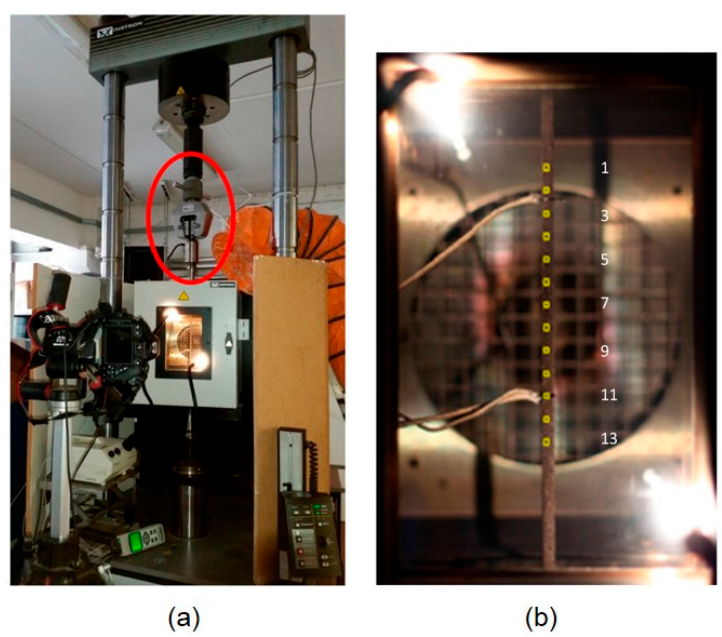
Figure 5. ( a ) Test setup with DIC camera in front of Instron 600 LX tensile testing machine equipped with environmental chamber; the upper tendon’s anchorage clamping device is highlighted; ( b ) Detail showing a CFRP specimen with three attached thermocouples and the DIC patch alignment/numbering for strain measurement.